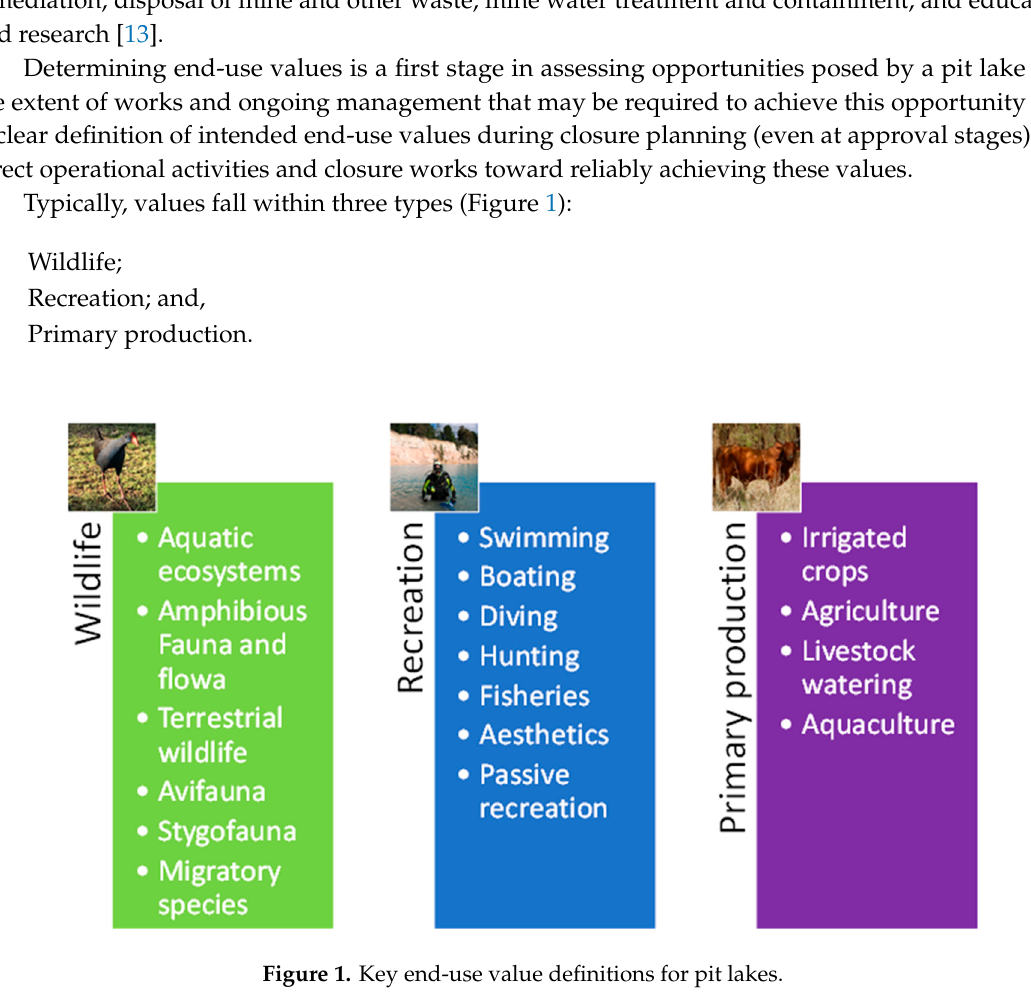
Figure 1. Key end-use value definitions for pit lakes.